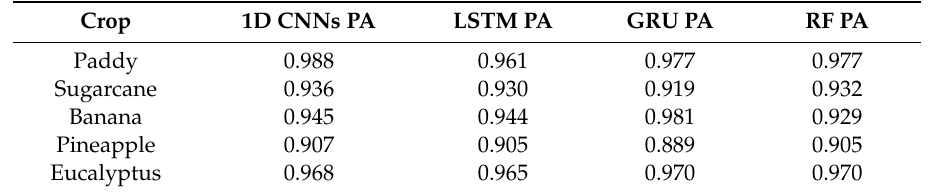
Table 5. Producer’s accuracy (PA) on the time series data with the maximum OAs. Bolded values are the best performances (PA) of each crop type in di ff erent classifiers.